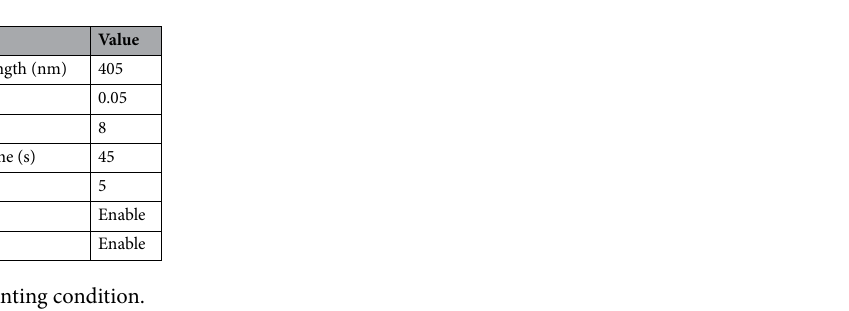
Table 3. 3D printing